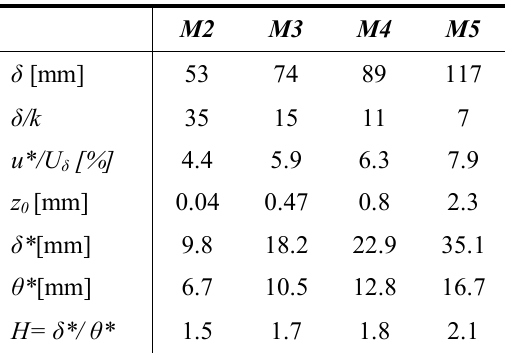
Table 1. Properties of the boundary layers.